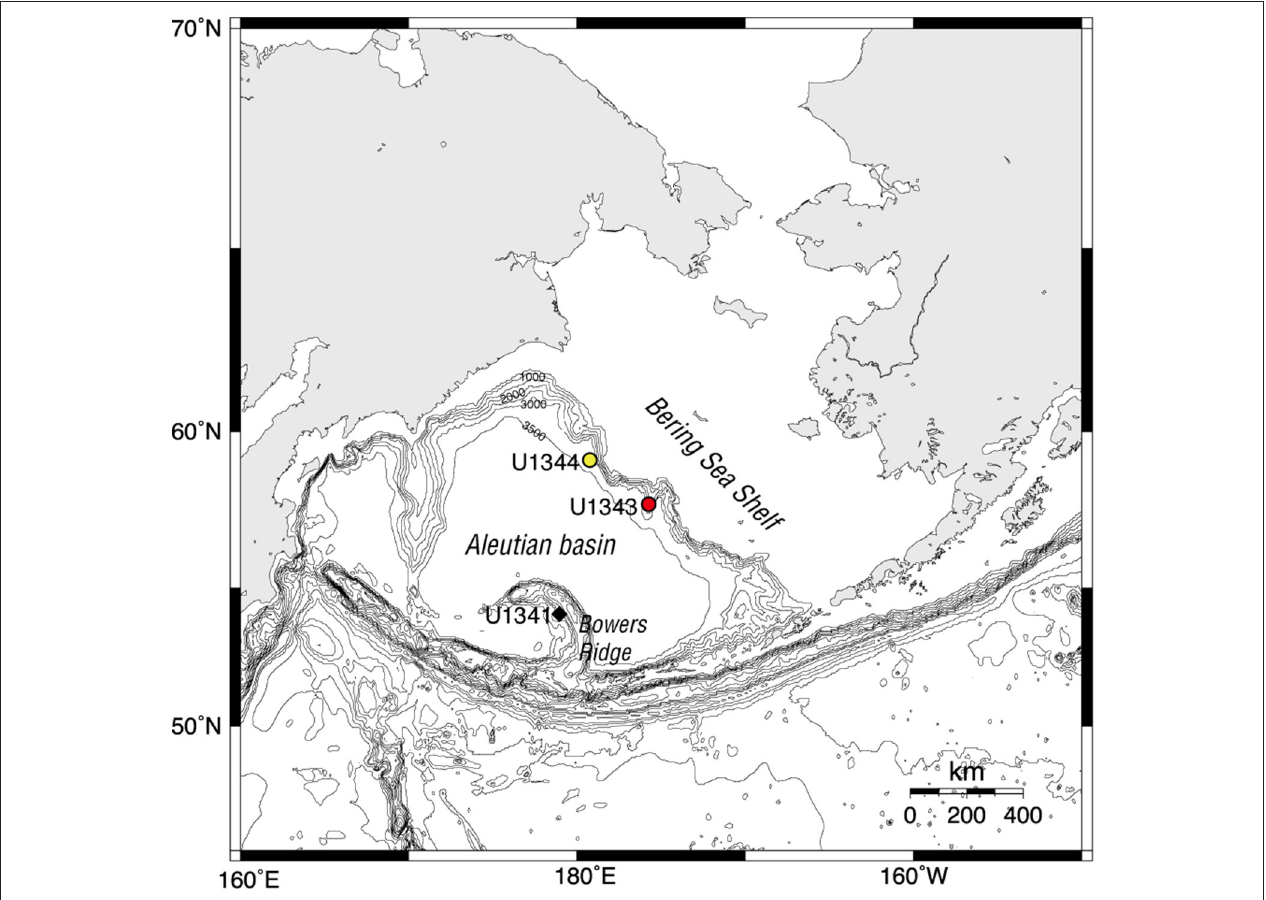
FIGURE 1 | Location map of the Bering Sea showing IODP Sites U1341, U1343, and U1344. The bathymetry map was reproduced from Ijiri et al. (2012) with the permission of the copyright holder (Elsevier) (License number: